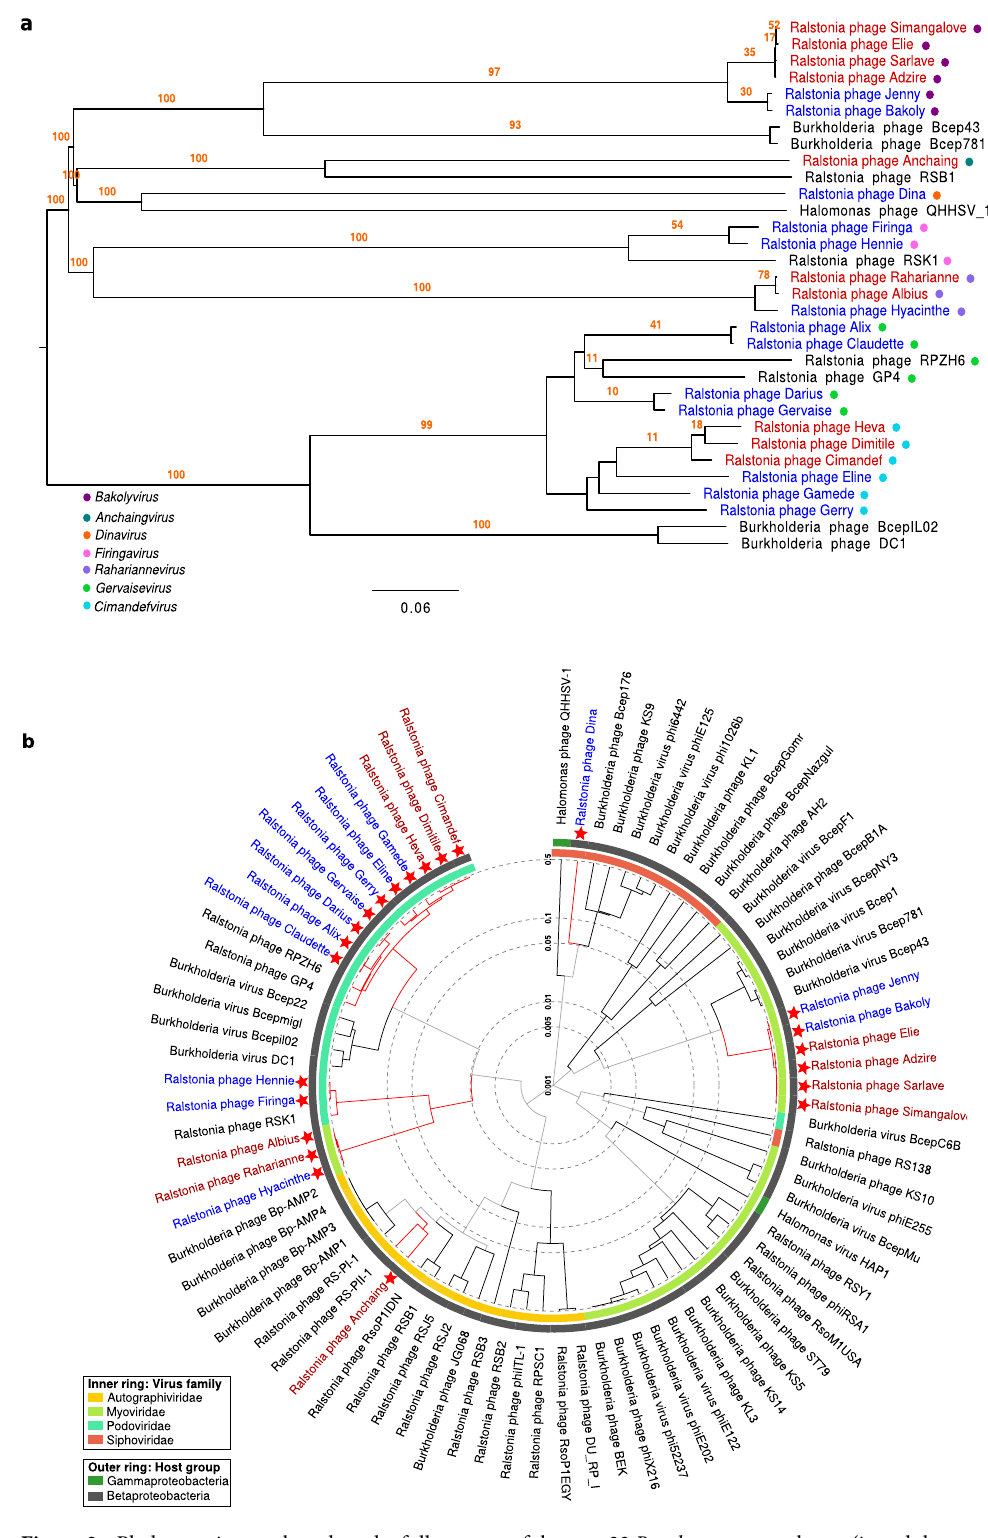
Figure 2. Phylogenetic trees based on the full genome of the new 23 R. solanacearum phages (in red those from Reunion island and in blue the ones from Mauritius). ( a ) Tree based in nucleotides including also the nine closest phage relatives (in black), calculated with VICTOR methods. The seven proposed genera are indicated by coloured dots on the left side of the tree. A bootstrap value of 100 was used in the analysis. ( b ) Circular proteomic tree generated by ViPTree including also all R. solanacearum (non-Inoviridae and non-jumbo), Burkholderia and Halomonas phages, coloured by virus families and host taxonomic groups. The new 23 R. solanacearum phages are indicated by red